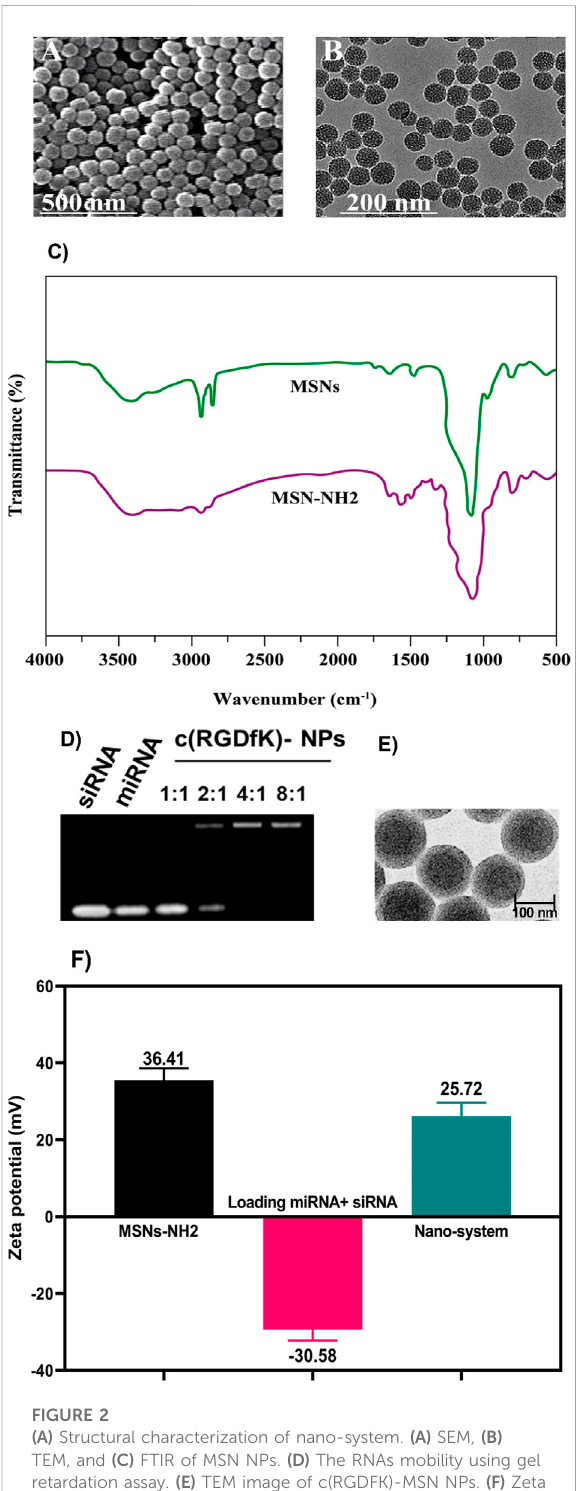
FIGURE 2 (A) Structural characterization of nano-system. (A) SEM, (B) TEM, and (C) FTIR of MSN NPs. (D) The RNAs mobility using gel retardation assay. (E) TEM image of c(RGDFK)-MSN NPs. (F) Zeta potential of the nanoparticles and the